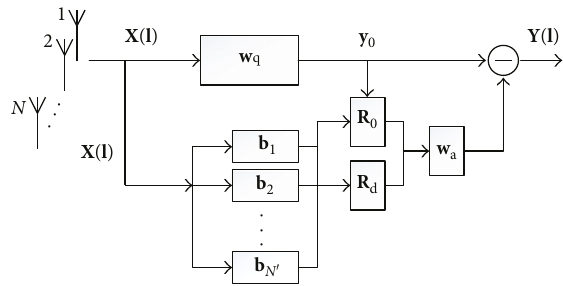
Figure 5: The framework of the proposed algorithm, where X l = x l , x l , … , x l T ∈ ℂ N × K is the channel-Doppler dimension 1 2 N data in the l th range cell and x n l ∈ ℂ 1× K denotes K Doppler sampling points in the l th range cell and n th element. w q is the static weight to keep the main beam direction and the level of side